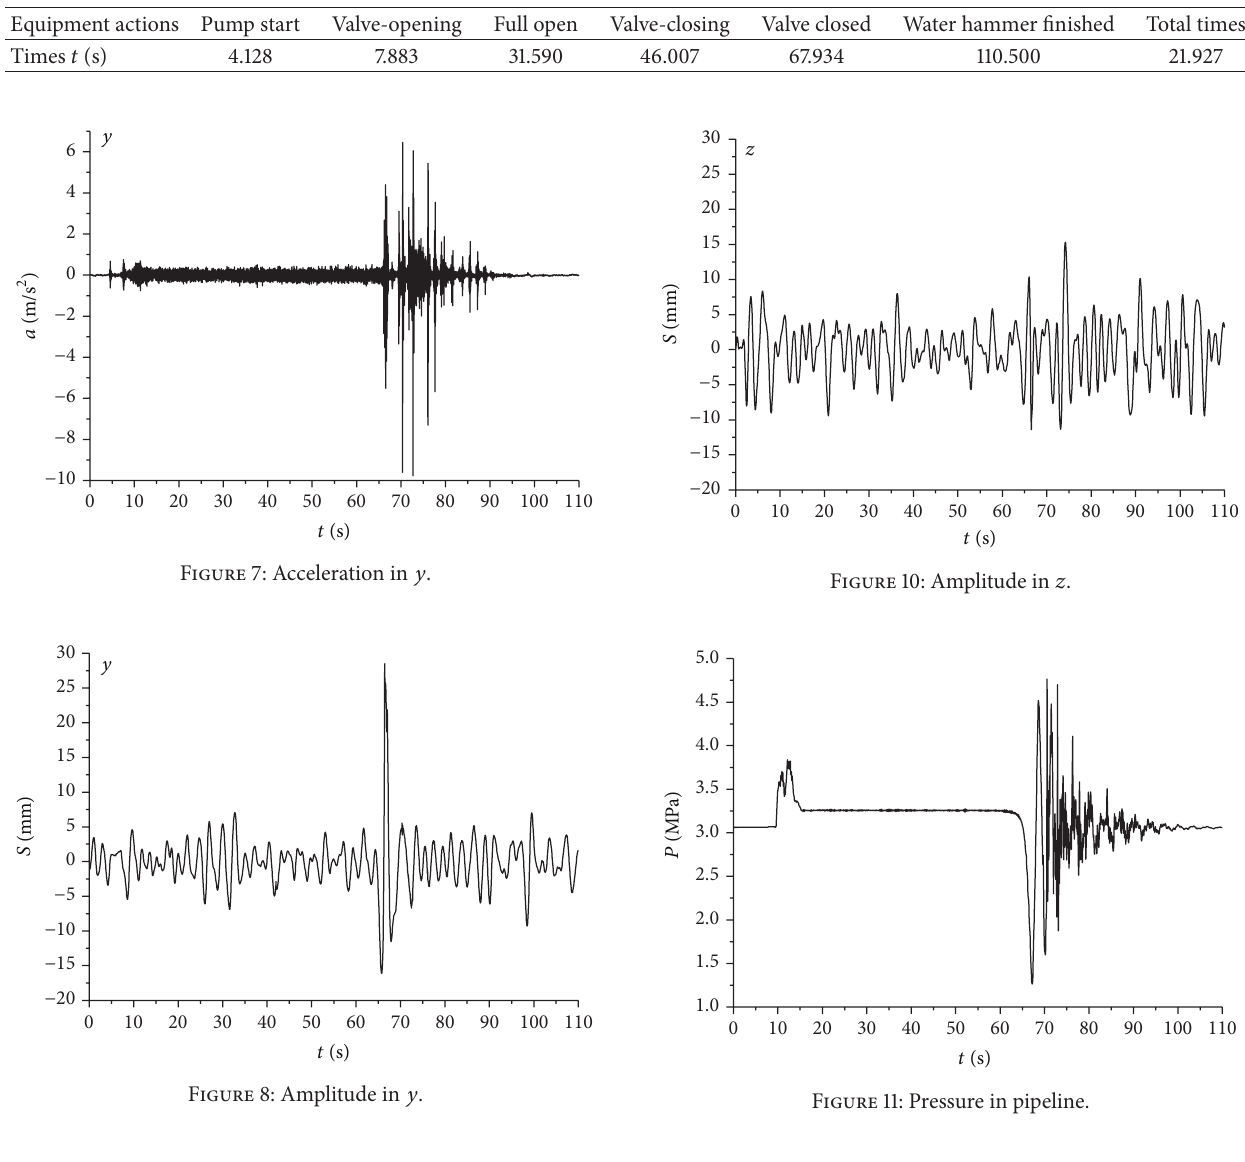
Table 1: Times of equipment in single-stage valve-closing.